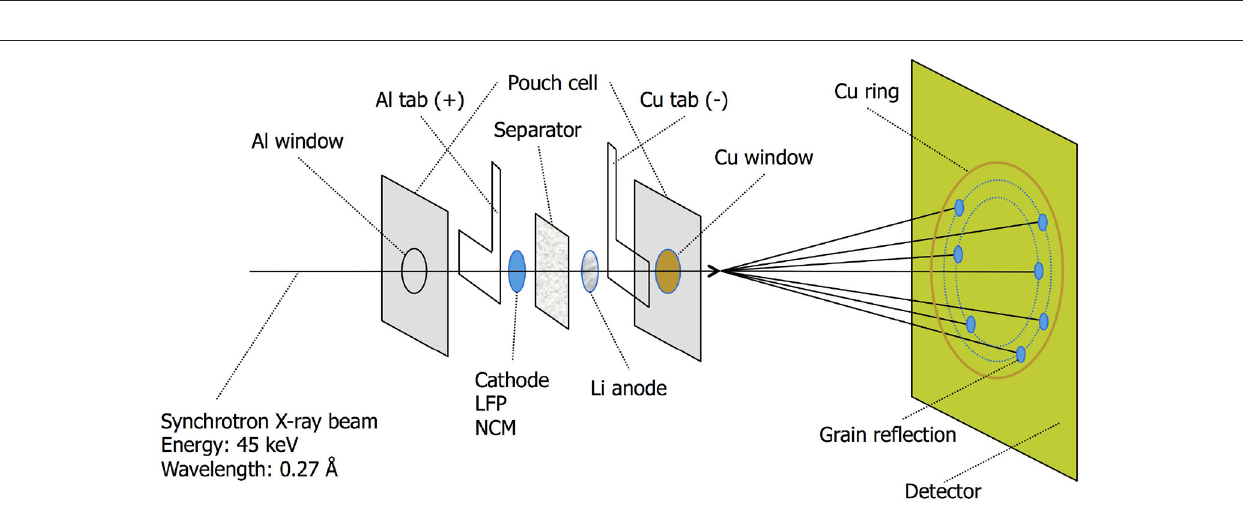
FIGURE 2 | ID11 X-ray synchrotron beamline passing through the various layers of the pouch cell. The microbeam causes the diffraction ring to break up in spots originating from single electrode grains.